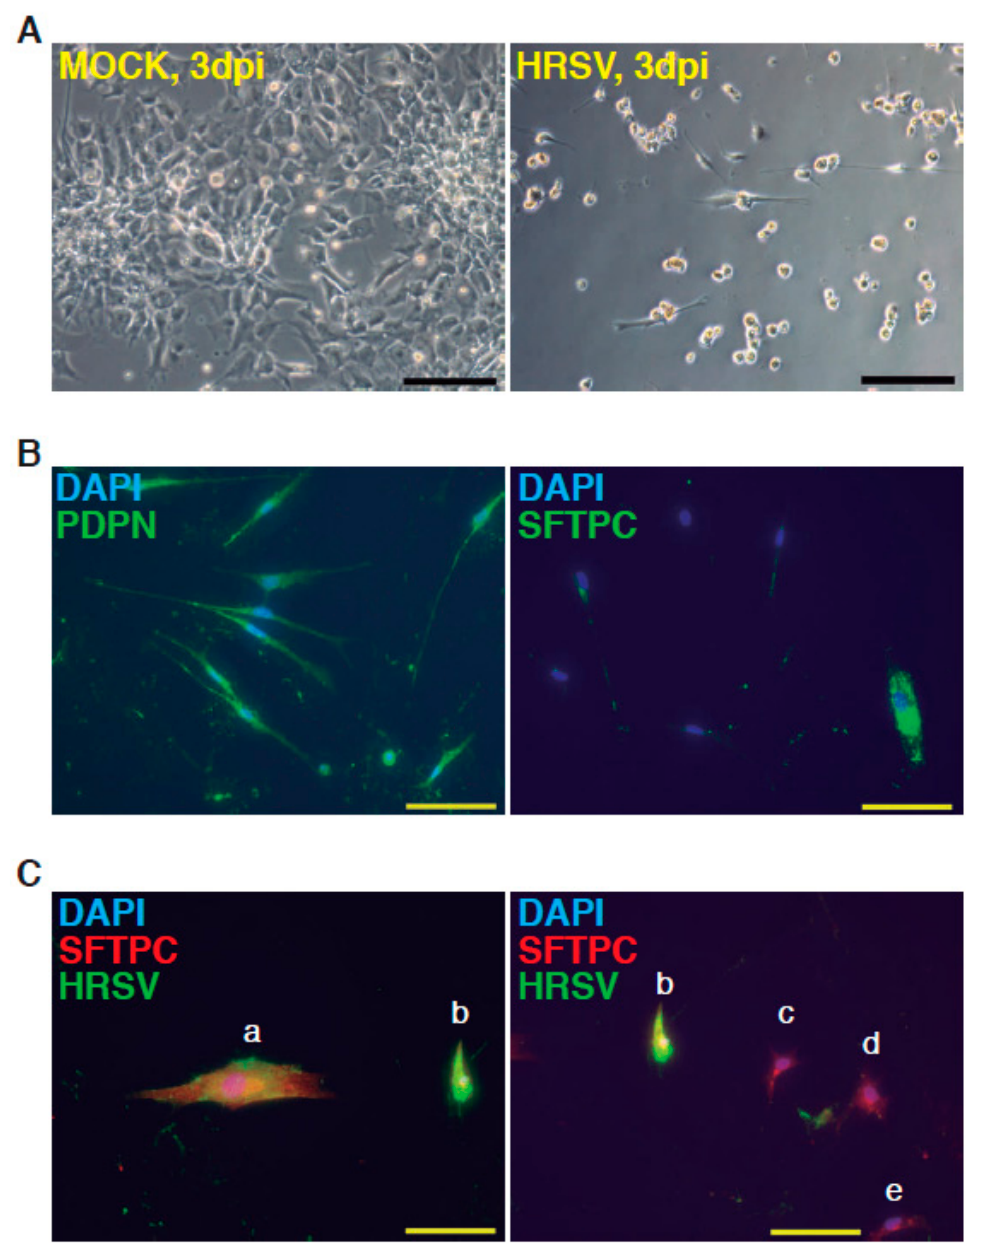
Figure 2. Infection of minilungs by human respiratory syncytial virus (HRSV) [moi (multiplicity of infection) 1]. ( A ) Representative bright field micrographs at 3 dpi (days post infection); scale bar: 100 µ m; ( B ) Detection by indirect immunofluorescence of ATI cells marker podoplanin (PDNP) and of ATII marker (SFTPC; mature surfactant C protein) in HRSV-infected cells; scale bars: 50 µ m; ( C ) Double detection of SFTPC and viral antigens by indirect immunofluorescence. Cells labeled as “a” and “b” show the merged colors. Cells “c”–”e” only express SFTPC. HRSV antibody used: mix of mAbs directed against HRSV (Supplementary Information).